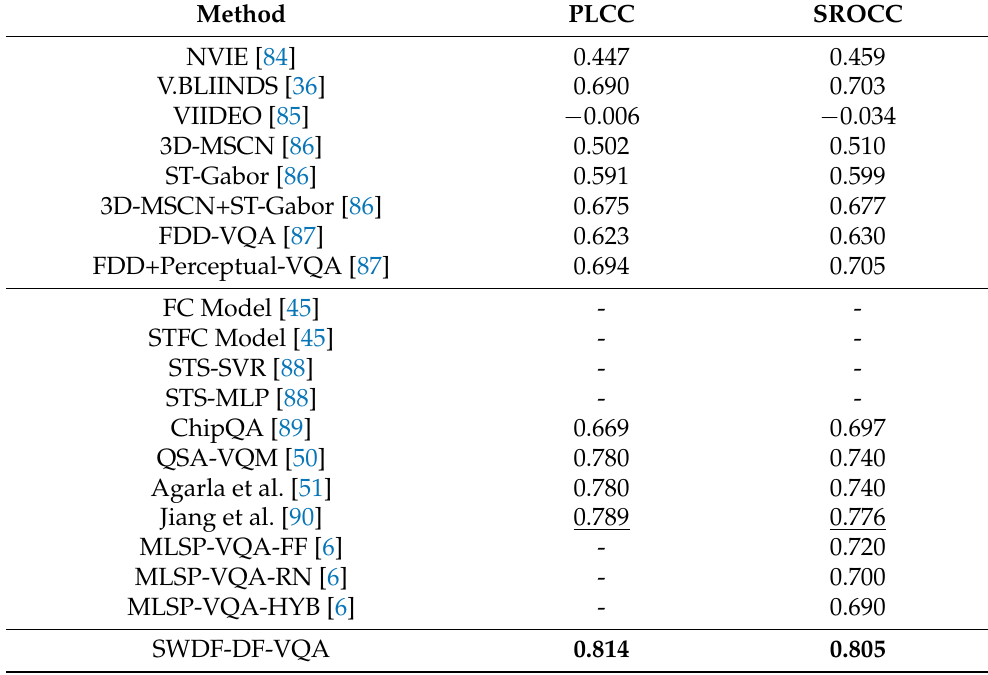
Table 10. Comparison of SWDF-DF-VQA to the state-of-the-art on LIVE VQC [26]. Median PLCC and SROCC values were measured over 1000 random train–test splits. The best results are in bold, while the second best results are underlined. We denote by “-” when the data are not